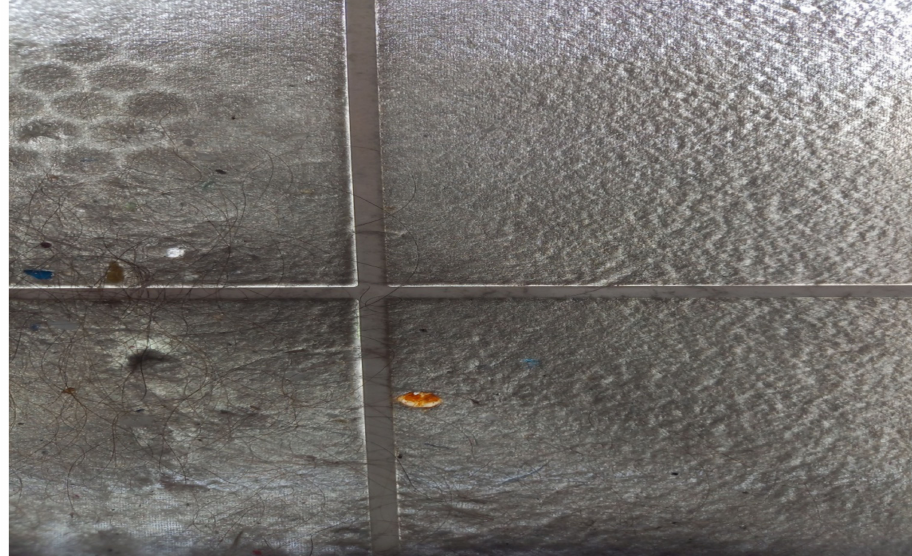
Figure 2. Close view of the sieve from the air purifier (School of Dentistry, National and Kapodistrian University of Athens).